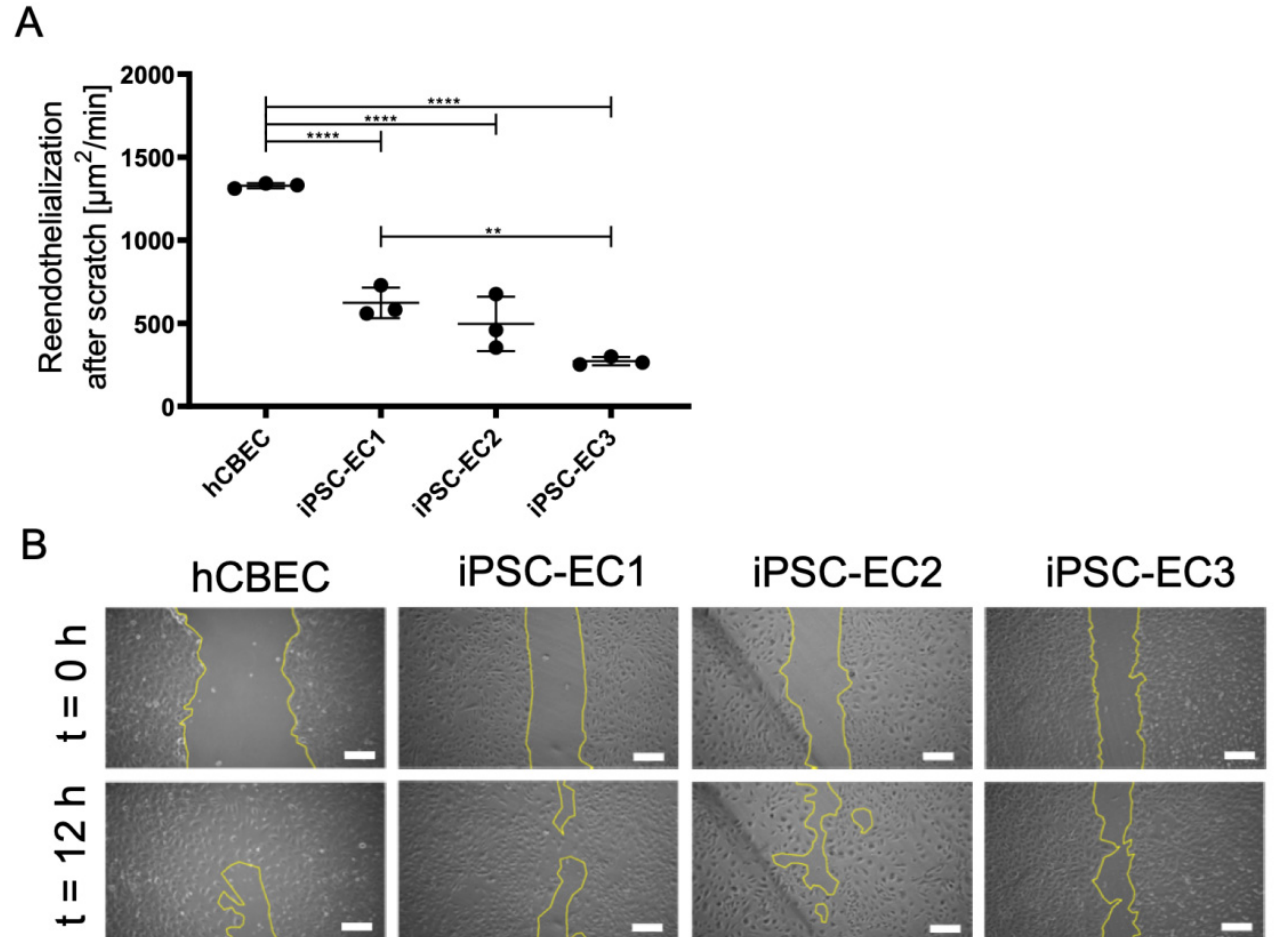
Figure 5. Regenerative capacity of endothelial monolayers on PMP gas exchange membranes. ( A ) Recovered area per minute. Results are given as means from independent triplicates with standard deviation. Analysis for statistically significant differences was performed using one-way ANOVA with Tukey’s post hoc test. Differences were considered significant at p < 0.01 (**) and p < 0.0001 (****). ( B ) Representative phase contrast pictures showing the scratched area at start (t = 0) of the experiment and after 12 h. Yellow lines indicate the cell-free area. Scale: 250 µm.